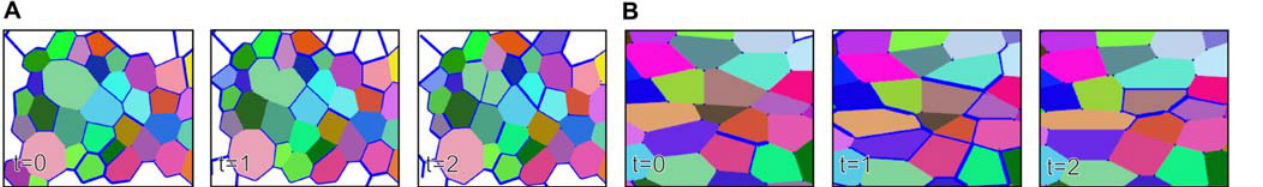
Fig 2. Detection of mitosis and apoptosis events. In addition to cell movements, notum morphogenesis involves extensive cell delamination at the dorsal midline [30] and extensive cell proliferation required for notum expansion [7]. We therefore incorporated into the tracker algorithms to detect mitotic and apoptotic events. A) The large light green cell in the upper left region splits to produce two daughter cells marked by the same color. B) The dark brown cell in the center reduces its area until it disappears.